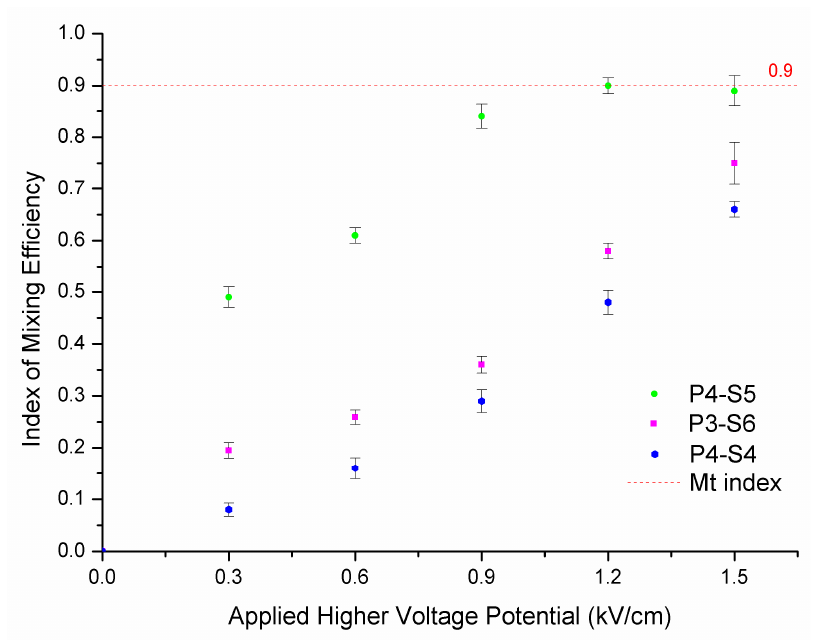
Figure 7. The index of the mixing efficiency with higher potentials.